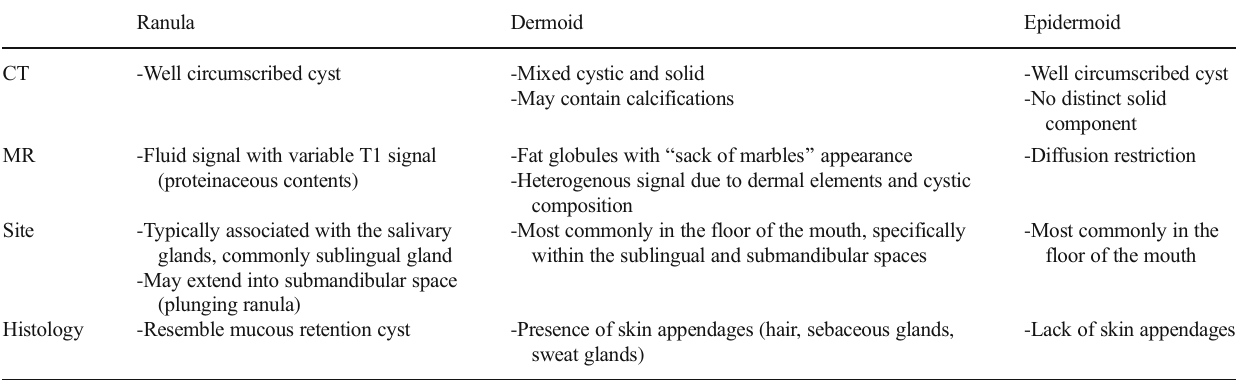
Distinguishing imaging features among cystic lesions in the sublingual and submandibular spaces Ranula